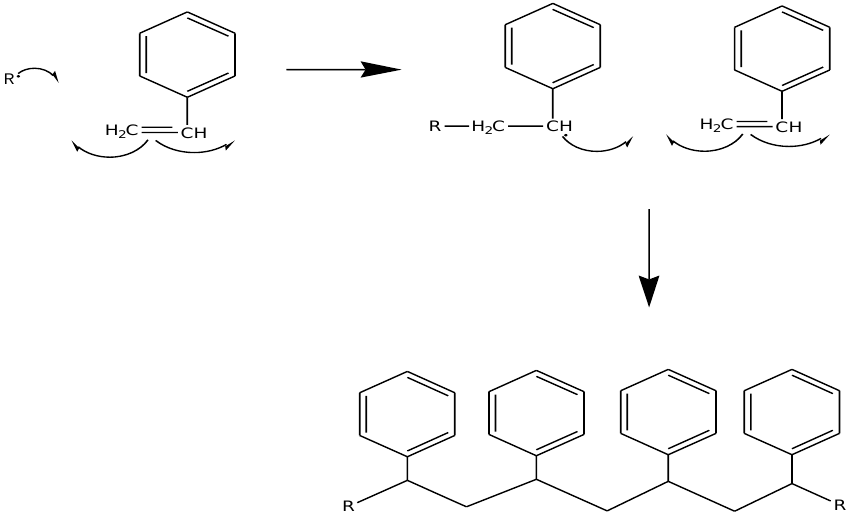
Figure 12 . Styrene polymerization by free radical formation via electrophilic